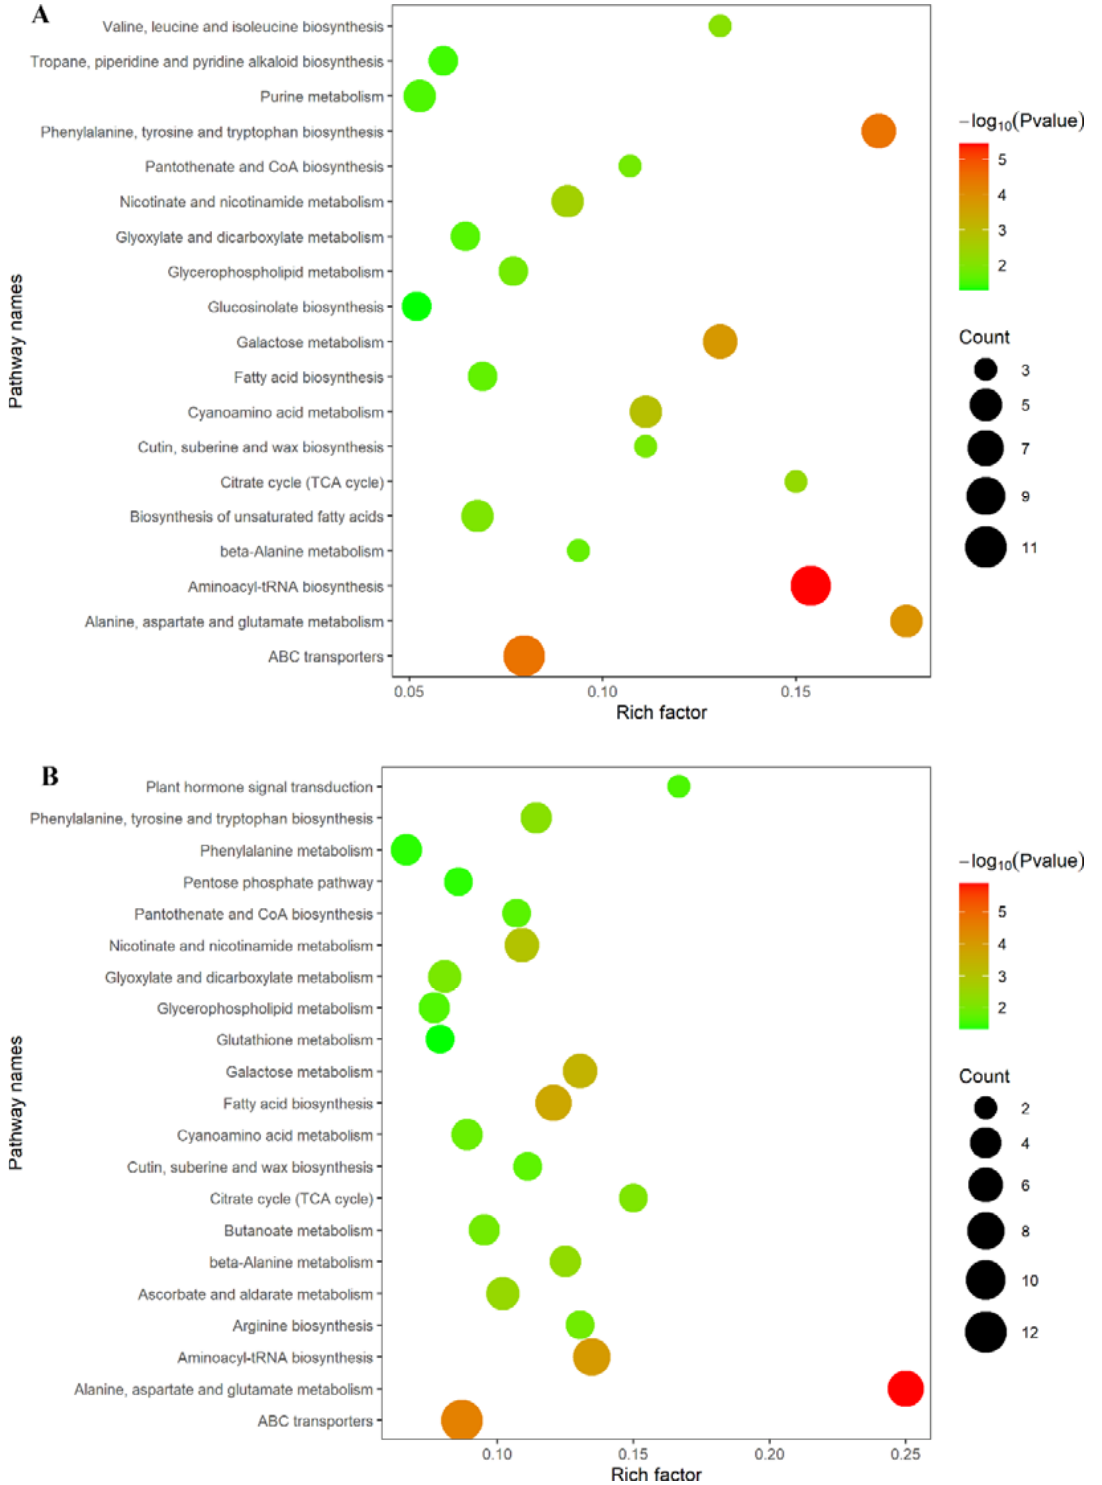
Figure 7. Analysis of metabolic pathways of TLS and TS. Results were from the analyses using the MetaboAnalyst 4.0 software. Every circle represents a metabolic pathway, with red color indicating higher impact and yellow color indicating lower impact. The size of the circle represents the number of DEMs participating in the pathway. ( A ) Rice samples at the TLS; ( B ) rice samples at the TS.